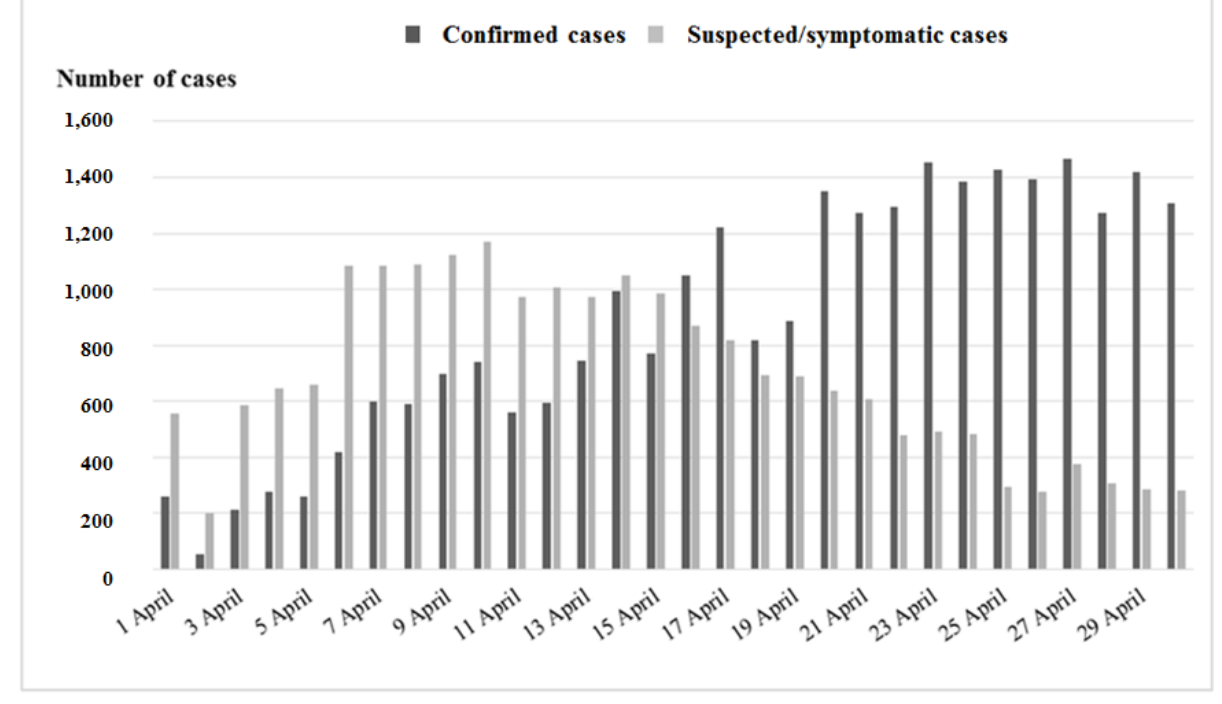
Figure 1. Numbers of suspected/symptomatic cases and confirmed cases of coronavirus disease among residents as reported by long-term care facility health care staff through COVIDApp over 30 days.